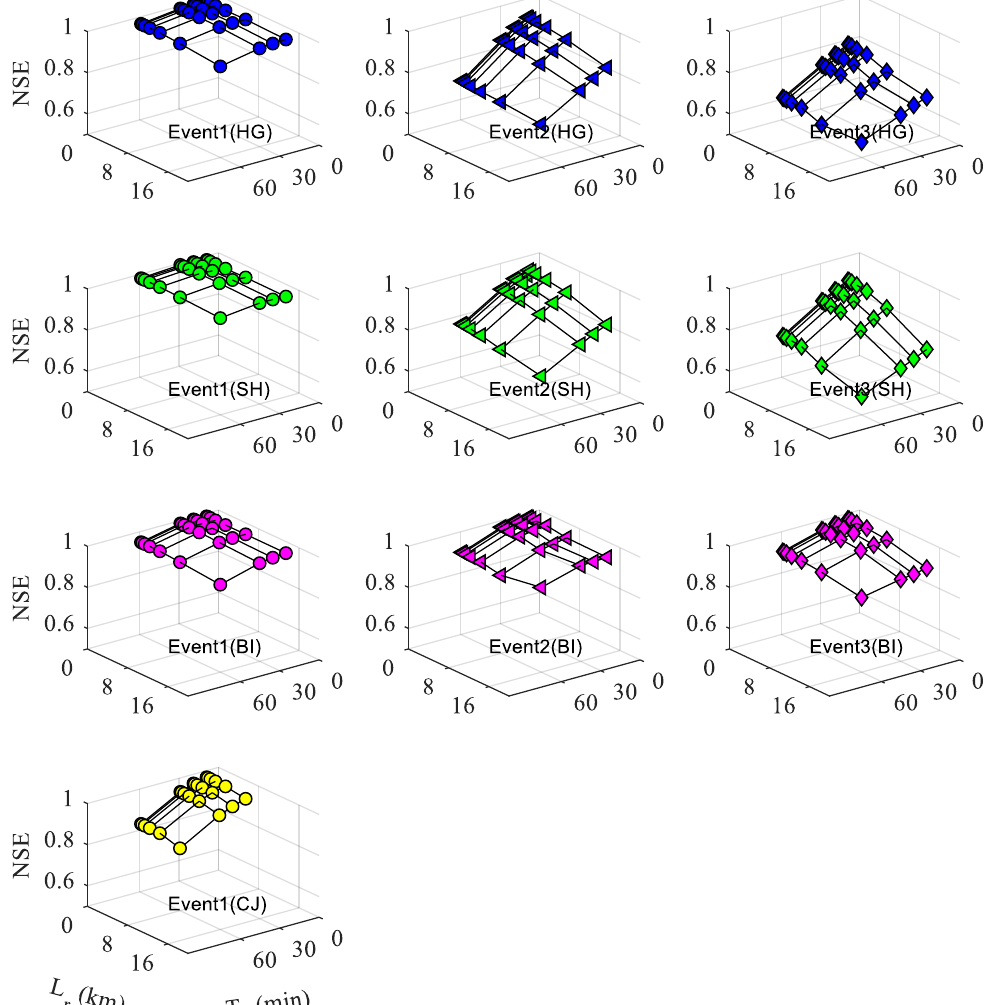
Figure 5. NSE values for runo ff predictions with various RSRs and rain temporal resolution (RTRs).